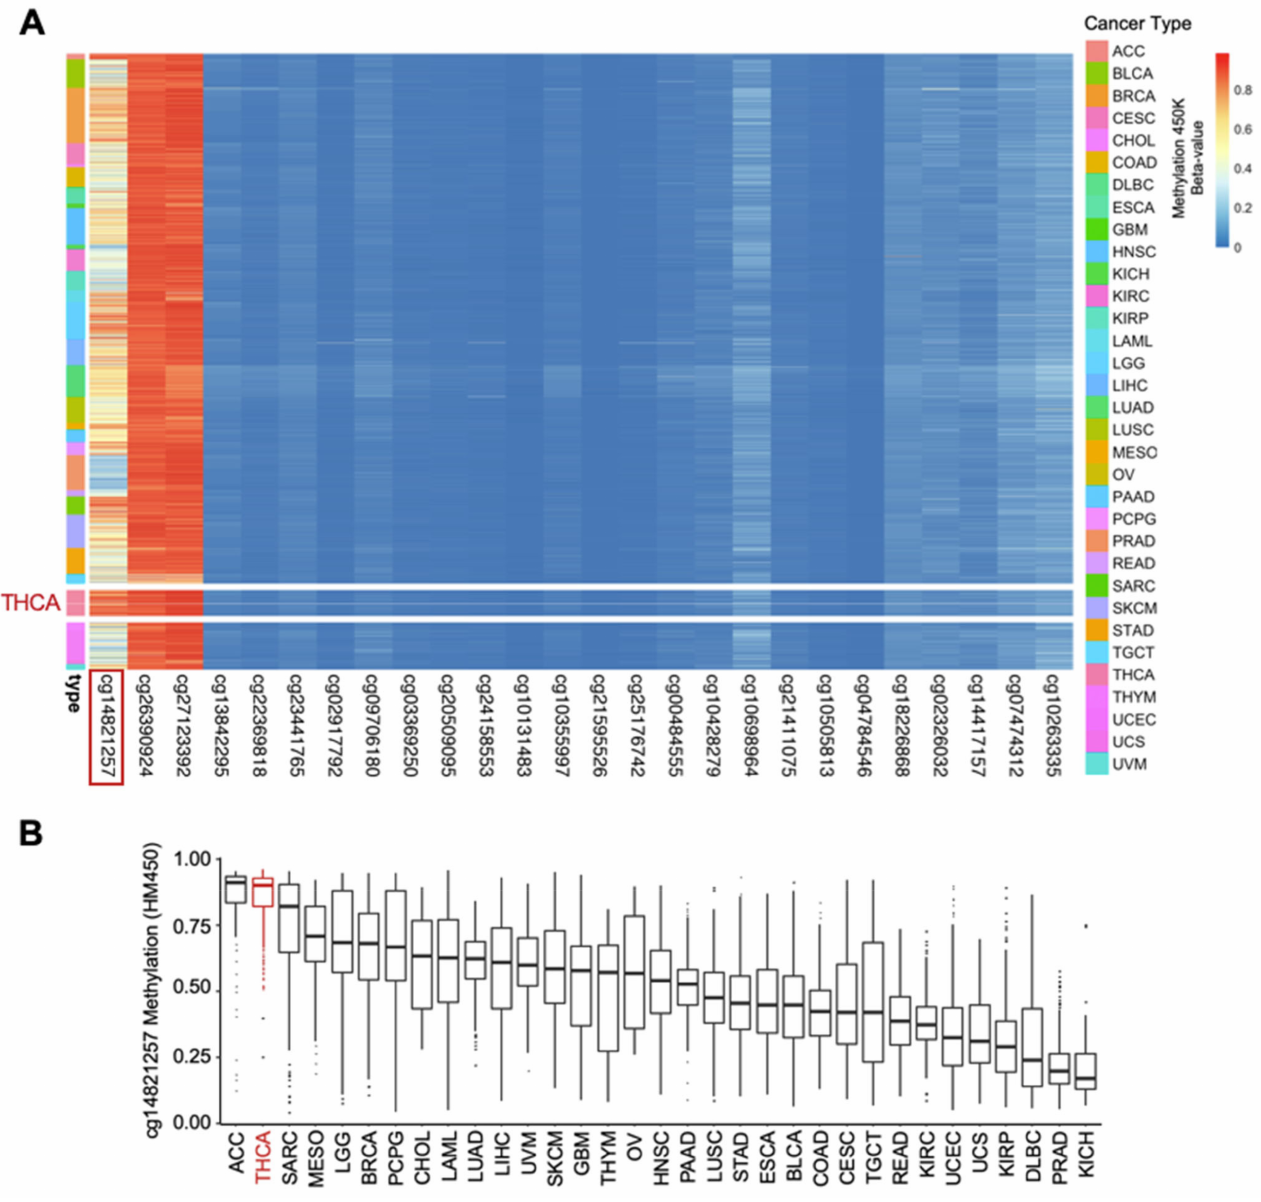
Figure 3. The methylation landscape of the GABPB1 loci across TCGA Pan-cancer. ( A ) Unclustered heatmap showing the methylation density ( β value) of the GABPB1 gene locus at various CpG sites based on methylation 450K across 33 cancer types. ( B ) Methylation of cg14821257 CpG site. Data are presented in Tukey boxplots with ranked order of cancer types based on median β